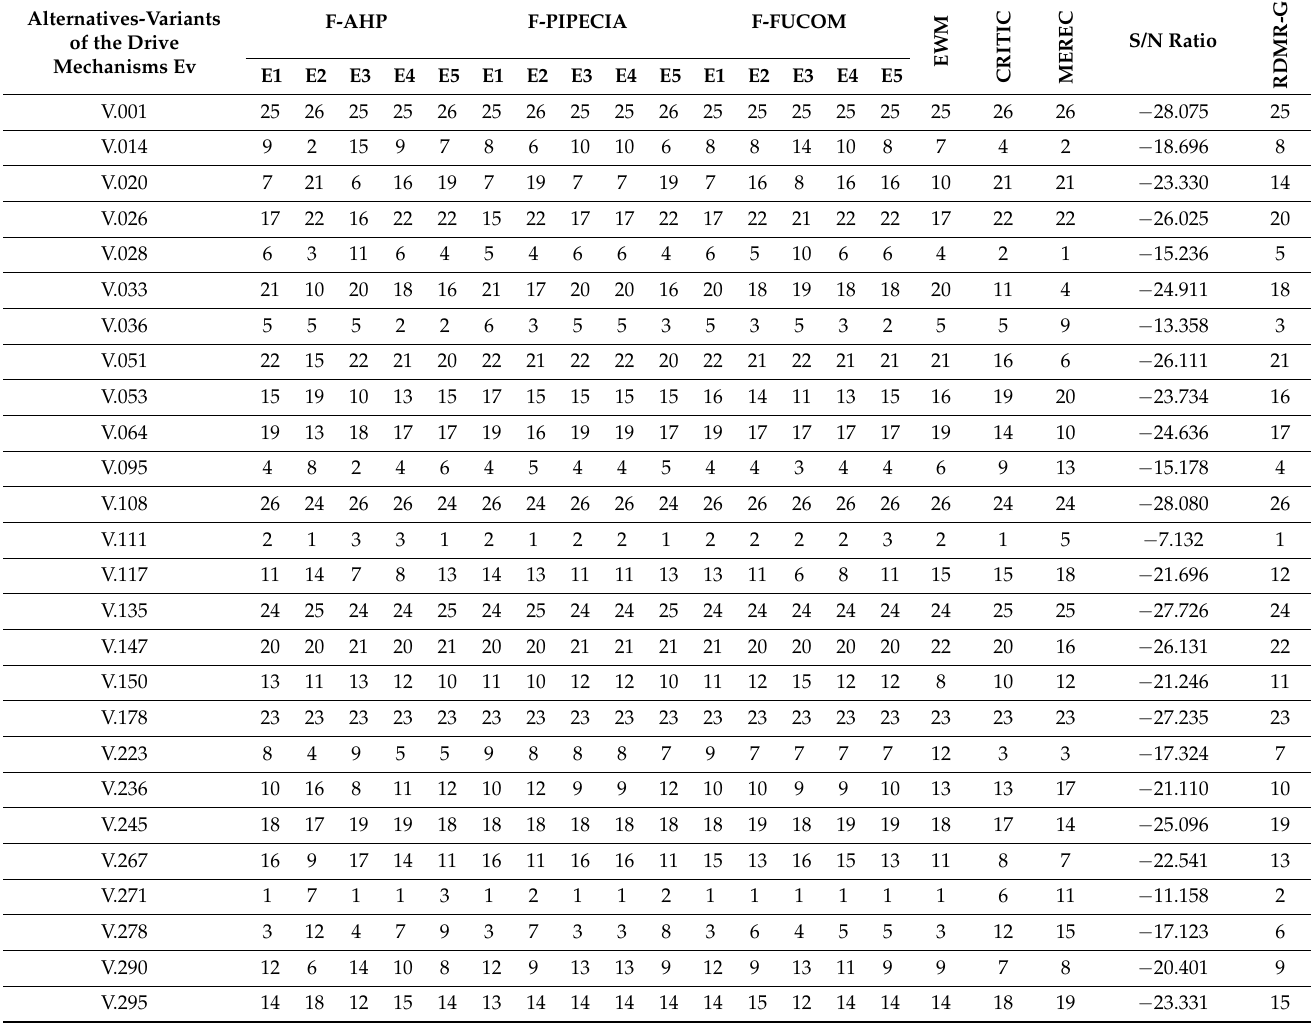
Table 5. Complete rankings of the alternatives according to different criteria